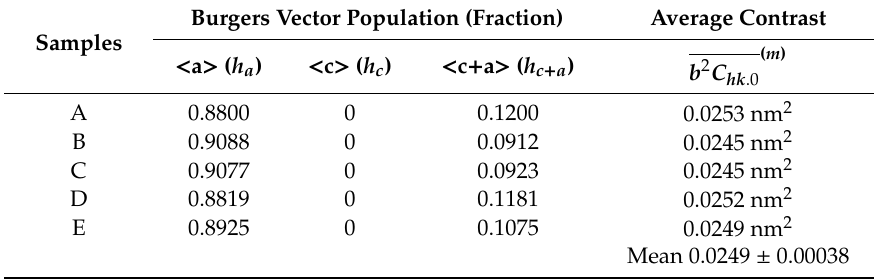
Table 4. The fractions of Burgers vector population and the b 2 C hk .0 samples of DMLS Ti6Al4V in the present work, based on the q -values in Tables 2 and 3, and based on the modified Williamson–Hall